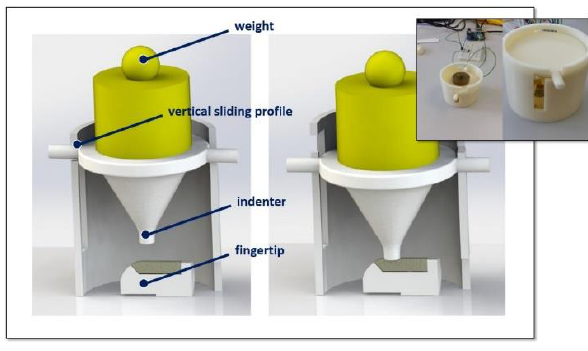
Figure 9. Design of the experimental equipment of testing the fingertip sensor with real load. On the top right panel of the figure is reported the manufactured equipment.